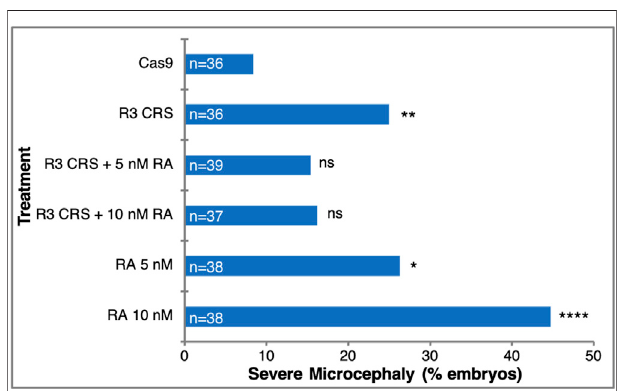
FIGURE 7 | RA rescues the microcephaly induced by loss of ALDH1A3 activity. Microcephaly was induced in Xenopus embryos by targeting the aldh1a3 gene with CRISPR/Cas9+sgR3. As controls, embryos were injected with Cas9 only. For rescue of the microcephalic phenotype, embryos were treated with 5 nM or 10 nM RA. The rescue ef fi ciency was calculated by Chi-square, comparing each treatment to the Cas9 control microcephaly level. *, p < 0.05; **, p < 0.01; ****, p < 0.0001; ns, not signi fi